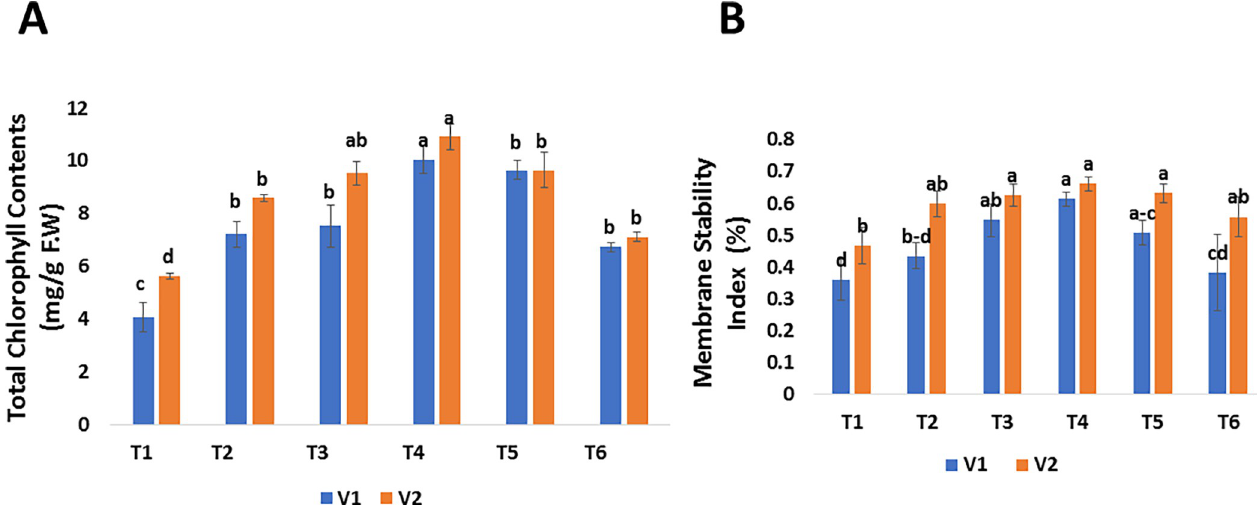
Fig 6. Effect of foliar applications of green synthesized SeNPs on physiological parameters of Mangifera indica under the stress of mango malformation disease. (A) Chlorophyll contents of M . indica in response to different treatments of SeNPs. (B) Membrane stability index of M . indica in response to different treatments of